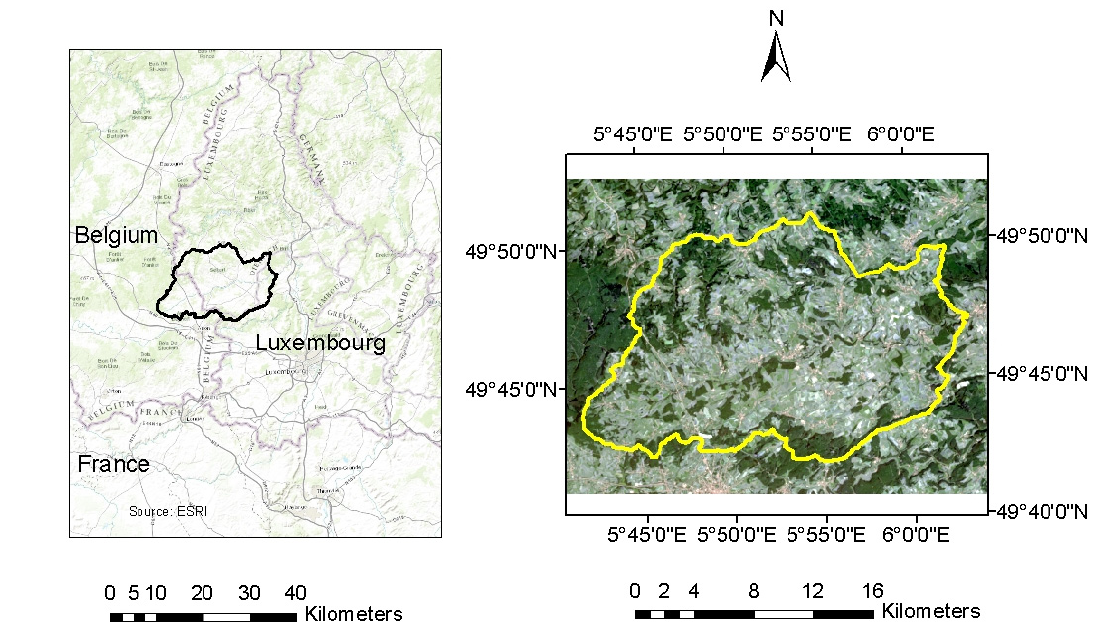
Figure 1. Illustration of the Attert catchment location crossing Luxembourg and Belgium in the ESRI map layout ( left ) and zoomed study area in yellow outline ( right ) with a Landsat 8 image of July, 2013 in RGB combination of band 3, band 2 and band